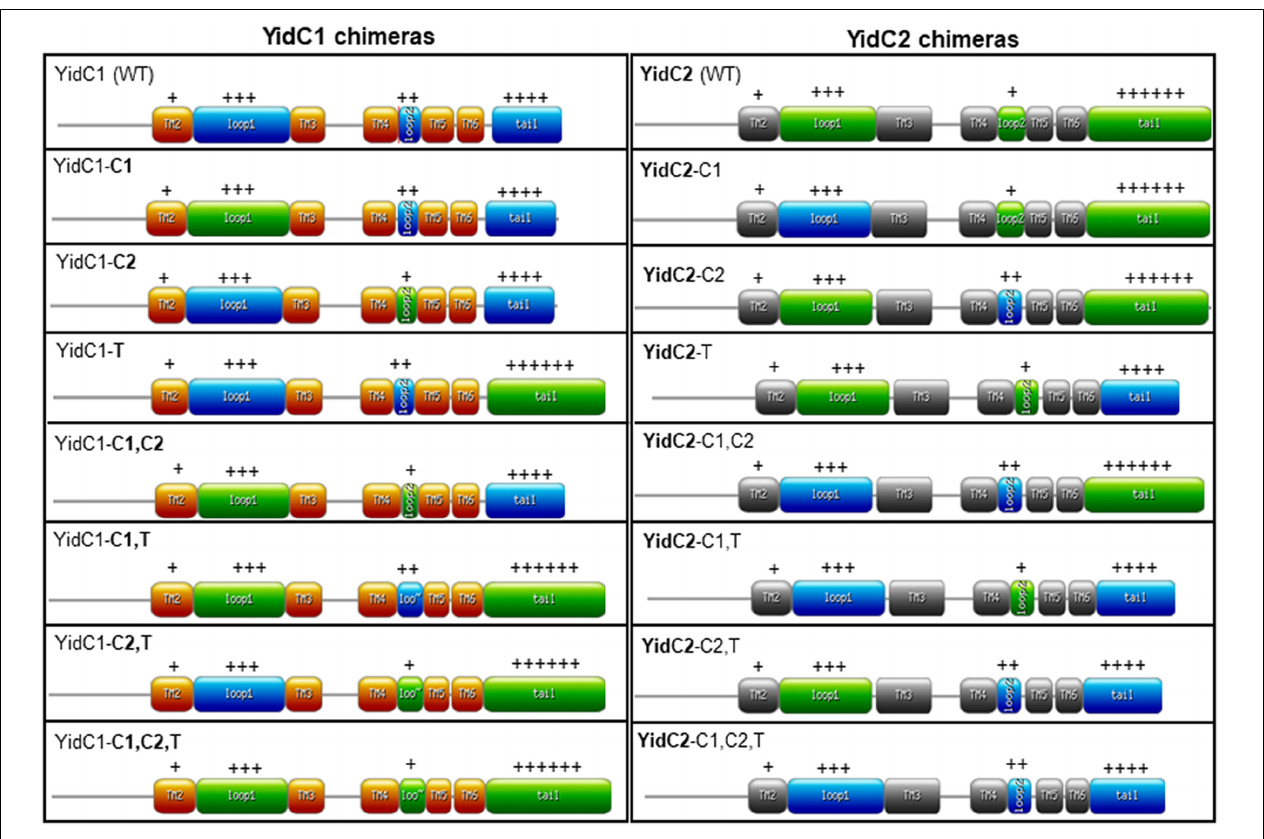
FIGURE 2 | Schematic representation of unmodified and chimeric YidC1 and YidC2 polypeptides. YidC1 transmembrane (TM) domains are illustrated in orange and cytoplasmic domains (CD) in blue. YidC2 TM domains are illustrated in gray and CD in green. Chimeric constructs were designed using the web-based https://prosite.expasy.org/mydomains/tool. Regular text indicates YidC1-derived backbone or CD. Bold text indicates YidC2-derived backbone or CD. “ + + + ” or “ + + + + + ” refers to the relative positivity of the charged C-terminal tails of Sm YidC1 and